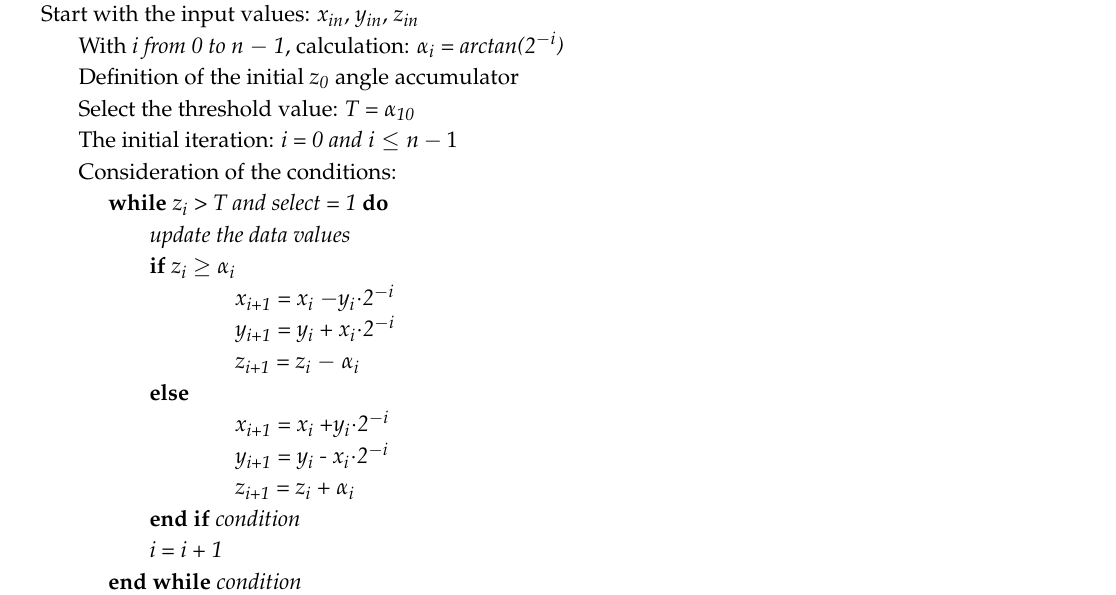
Algorithm 1 The m-CORDIC using the controllable iterative